Question: Give a one-sentence summary of this figure.
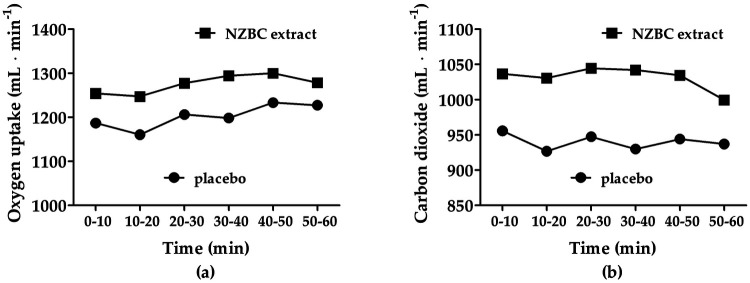
Answer: Oxygen uptake (a) and carbon dioxide production (b) for placebo and New Zealand blackcurrant extract during a 1-h moderate-intensity treadmill run at 50% V ˙ O 2 max .